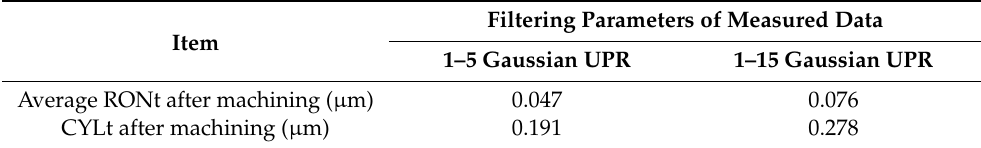
Figure 11. Surface morphology before and after simulated machining under different filtering parameters: ( a ) 5 UPR filtering before machining; ( b ) 5 UPR filtering after machining; ( c ) 15 UPR filtering before machining; ( d ) 15 UPR filtering after machining. Table 1. Comparison of average roundness error (RONt) and cylindricity error (CYLt) after simulation processing under different filter parameters.